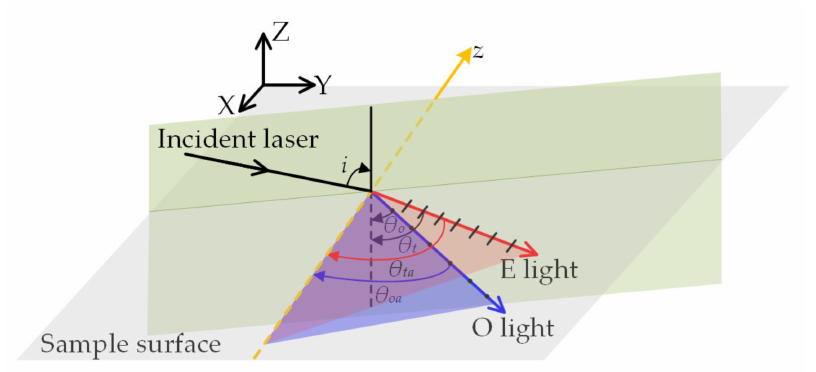
Figure 5. Relationship of O light (E light) and incident laser, or